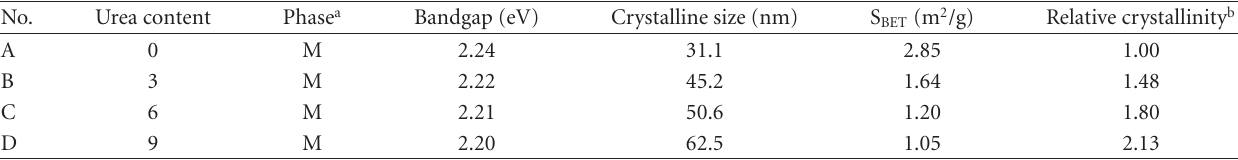
Table 1: Experimental conditions for preparation of the samples and their physical properties.